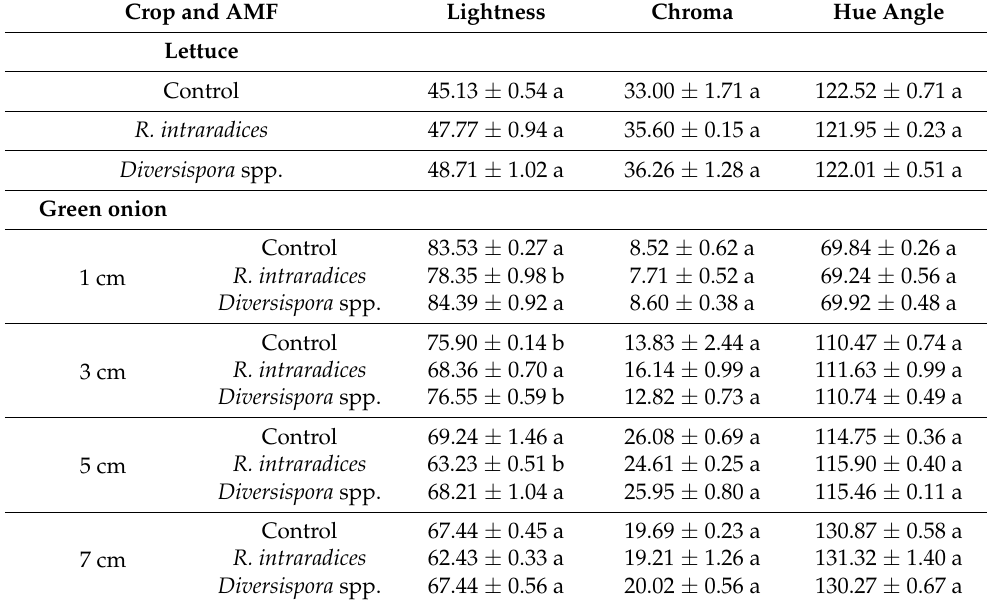
Table 2. Color parameters of lettuce and green onion leaves after application of two arbuscular mycorrhizal inocula ( R. intraradices or Diversispora spp.) or without (control). Different letters within a column (average values ± SE) indicate significant differences ( p < 0.05).